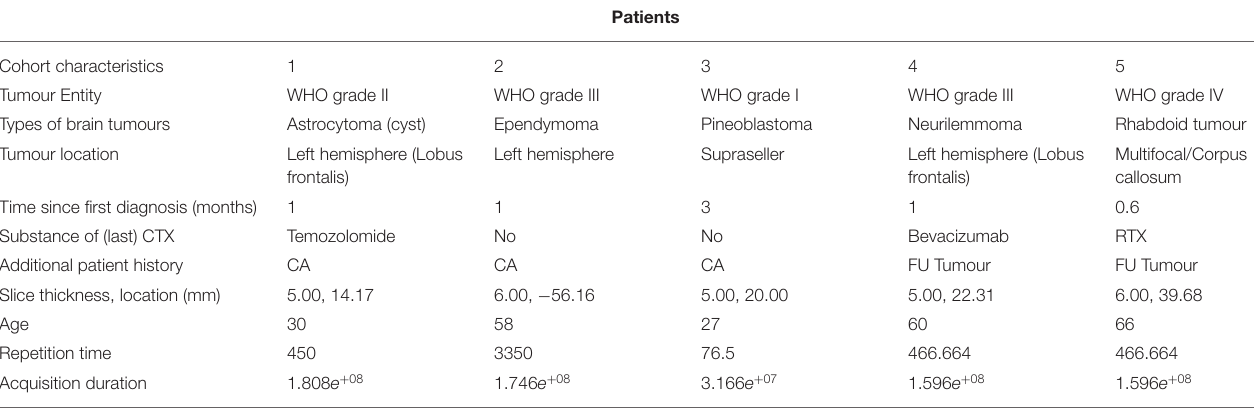
TABLE 1 | Cohort characteristics of five